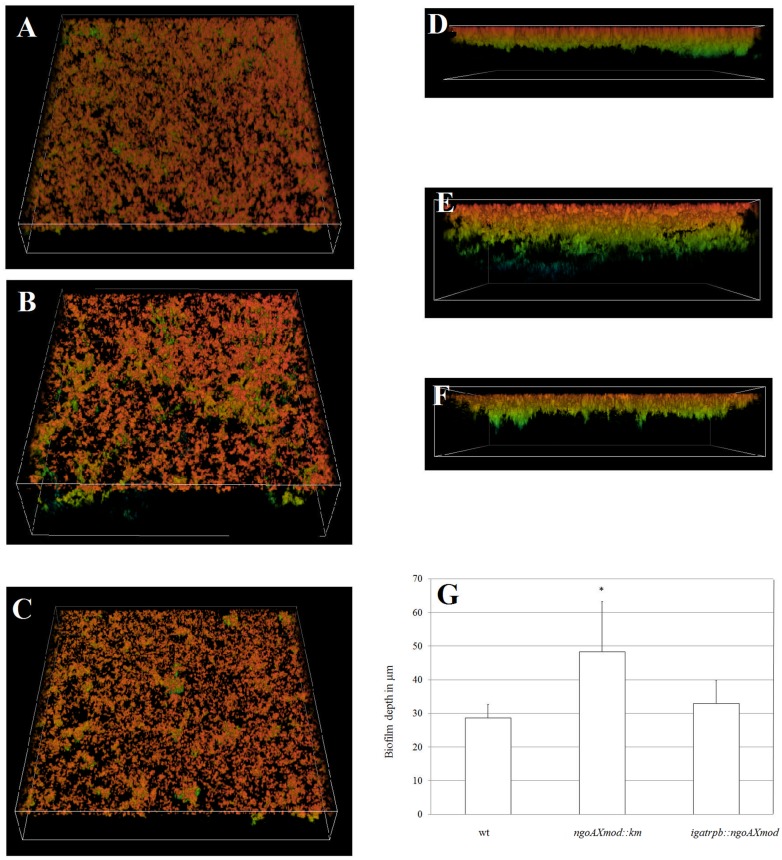
Three-dimensional biofilm structures visualized by SCLM produced by N. gonorrhoeae after 24 h. (A–C) Three-dimensional biofilm structures and density; (D–F) biofilm thickness. (A) and (D) biofilm produced by the wt strain; (B) and (E) biofilm produced by the gonococcal ngoAXmod::km mutant; (C) and (F) biofilm produced by the gonococcal igatrpb::ngoAXmod mutant (G) biofilm thickness in μm as measured by the NIS-ELEMENTS software. Experiments were triplicated and representative images are shown.